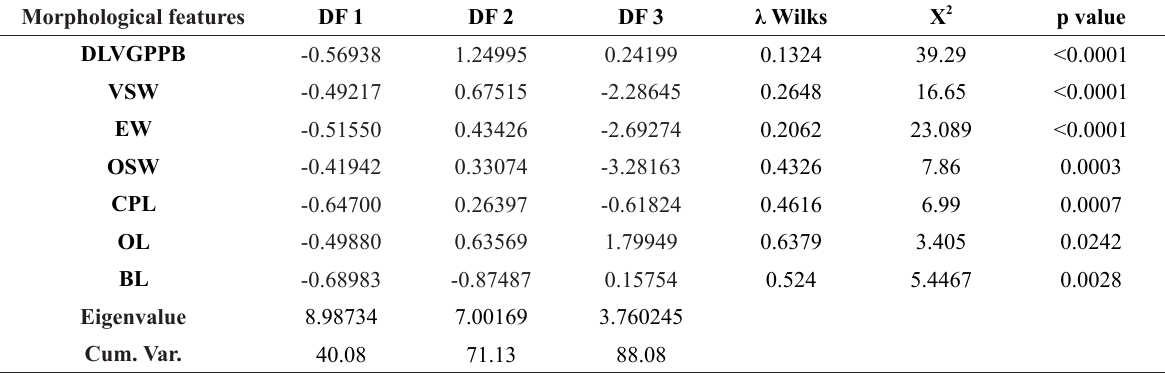
Canonical discriminant function coefficients of divergent morphological features among populations. Cumm. Var.: Cumulative